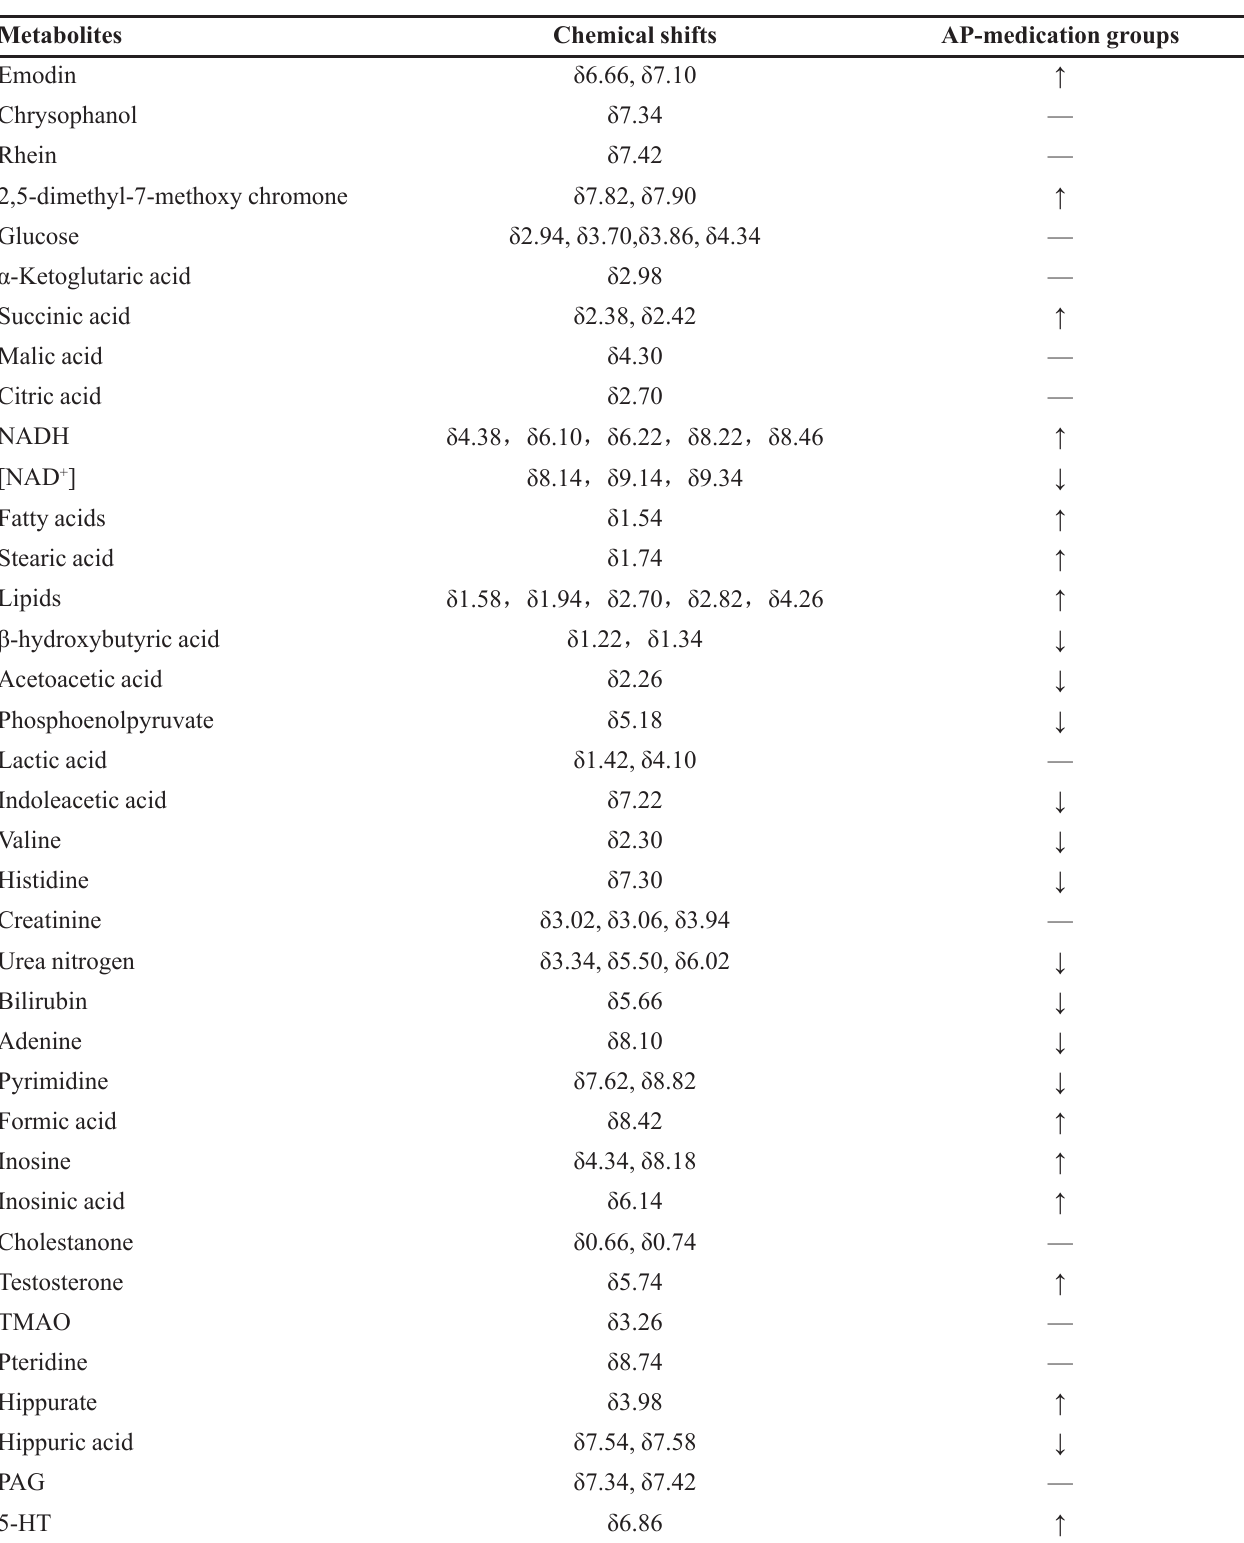
TABLE III - Summary of the variations in metabolites detected in the serum samples from the medication groups compared with the acute pancreatitis (AP) groups